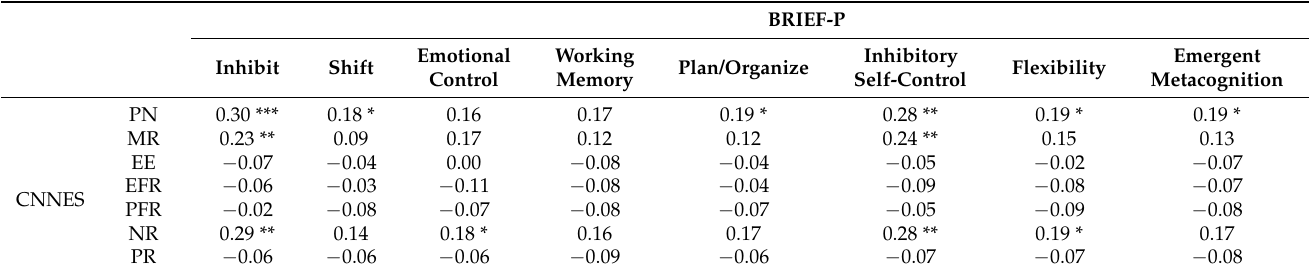
Table 3. Associations between mother’s report on CCNES and BRIEF-P scales, controlling for child’s sex and age.